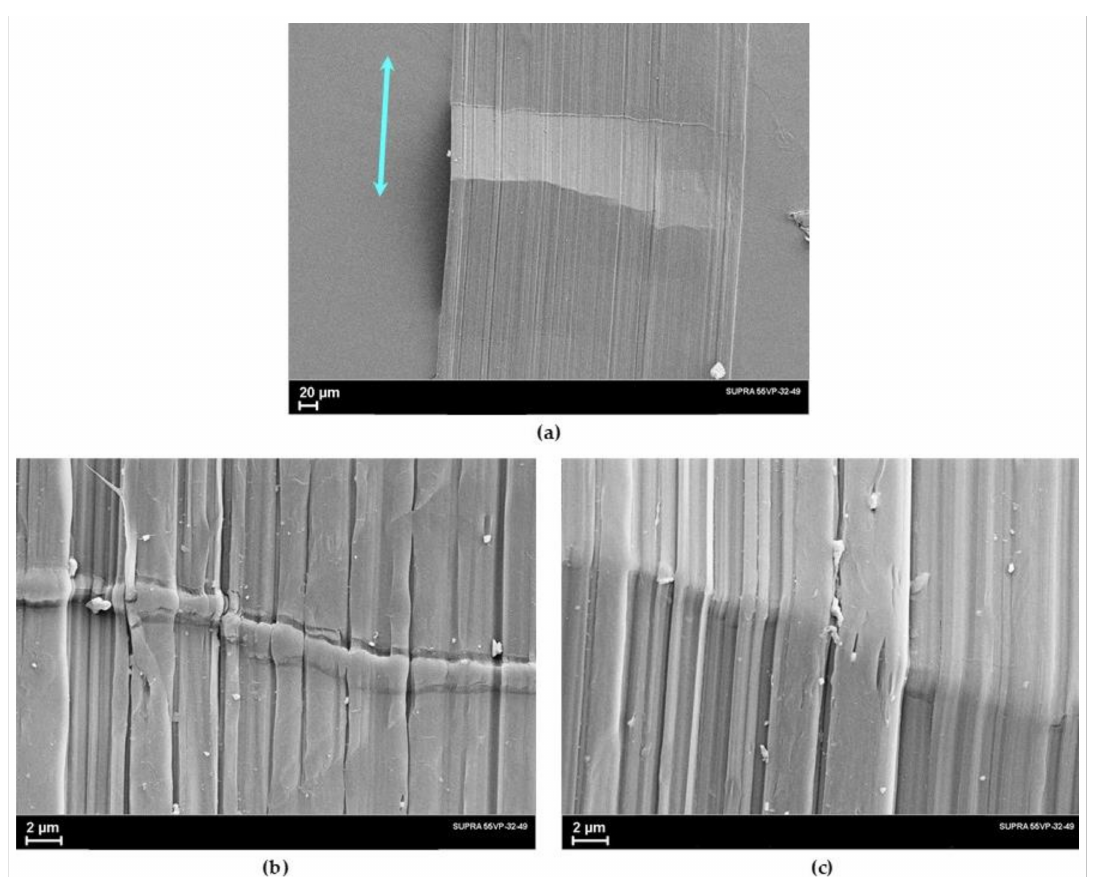
Figure 9. SEM images of the kink-bands on oriented UHMWPE film: ( a ) low magnification; ( b , c ) high